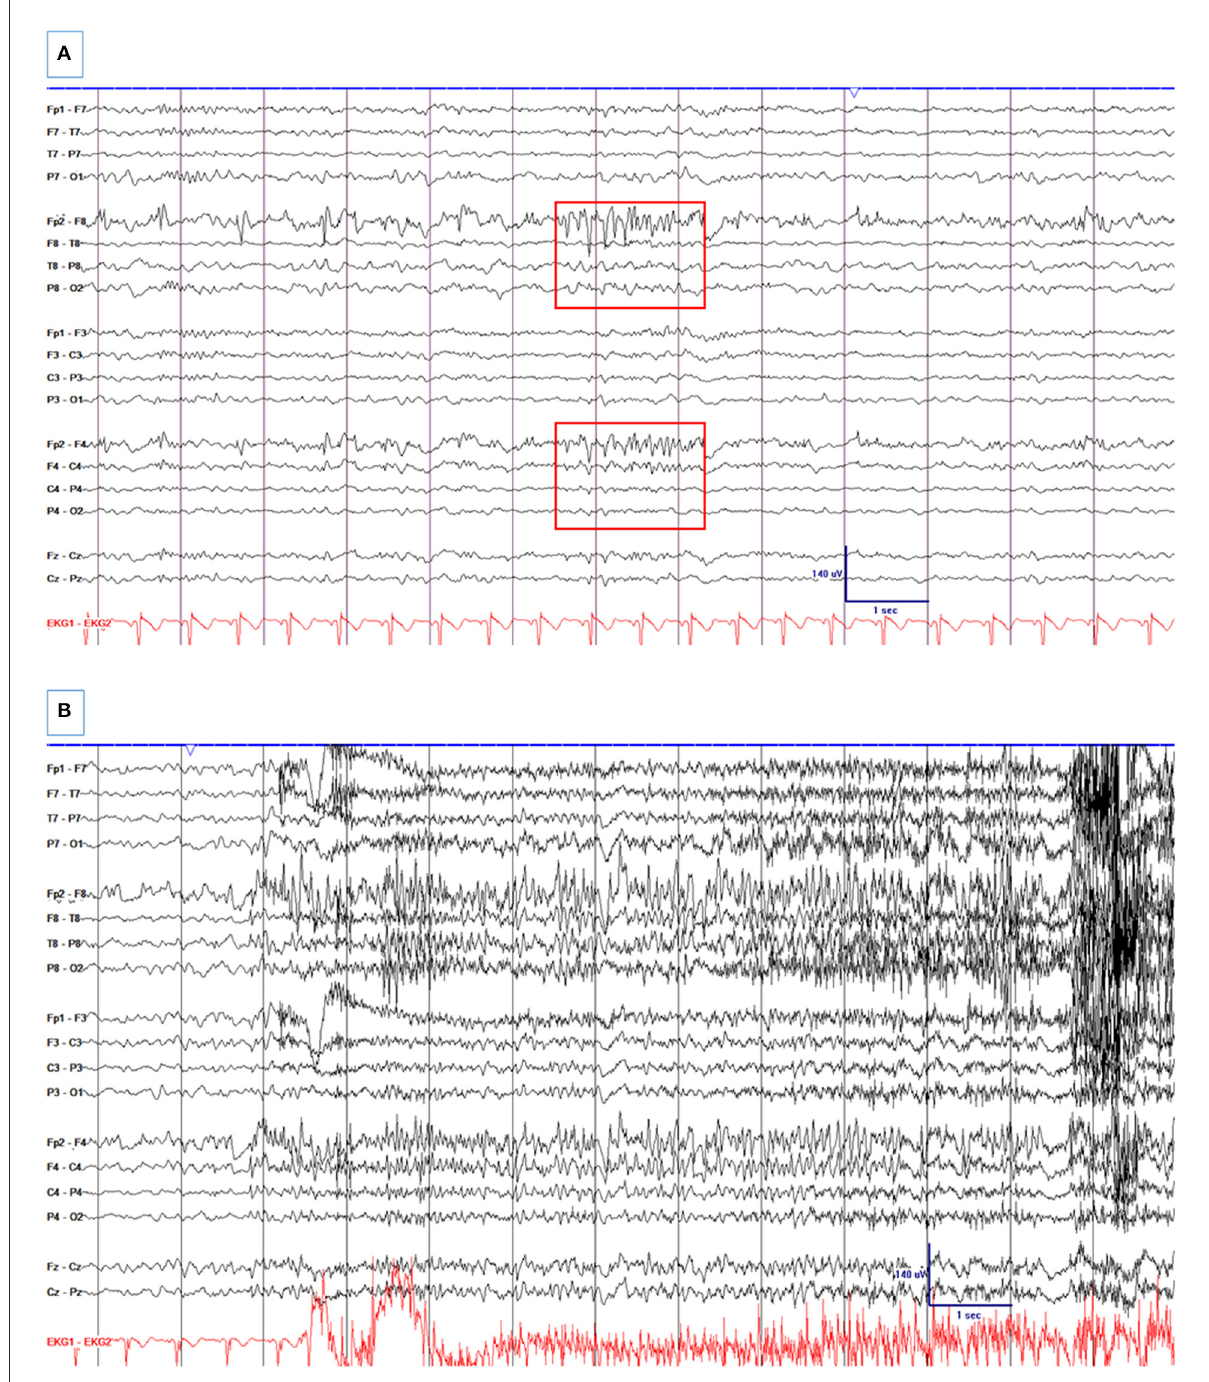
FIGURE2 A 33-year-old woman with a remote history of traumatic brain injury at age two with a right frontal encephalomalacia and surrounding gliosis and drug-resistant epilepsy, who was electively admitted for pre-surgical evaluation. (A) Right frontal spikes and R frontal non-evolving BIRDs (Box 1). There is a right frontal breach rhythm. (B) A seizure from the right frontal region. High- and low-pass filters were set at 1 and 70Hz, respectively. The notch filter was